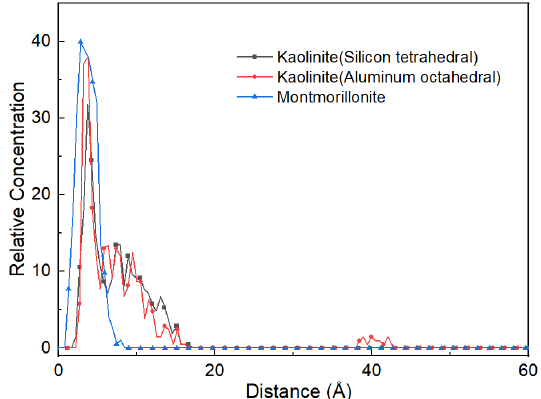
Figure 5. Electron density difference of ( a ) alumina octahedral surface–naphthalene, ( b ) silicon tetrahedral surface–naphthalene.